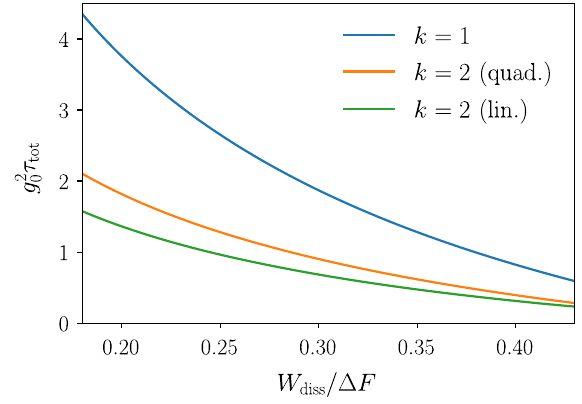
FIG. 11. Total protocol time as a function of dissipated work in ∈ the RL model. Each curve is generated by varying g 2 0 τ weak tot 30 fixed. The curves for k ¼ 2 = τ weak ½ 0 . 5 ; 5 (cid:2) while holding τ weak on ¼ iso k τ weak show both linear scaling, τ , and quadratic scaling, on ¼ on τ 2 ε 0 . 01 , βε 1 . 1 , k 2 τ weak . Parameters are ε , g 2 0 = ε f ¼ i i ¼ i ¼ on on ¼ 100 . and Λ = ε i ¼